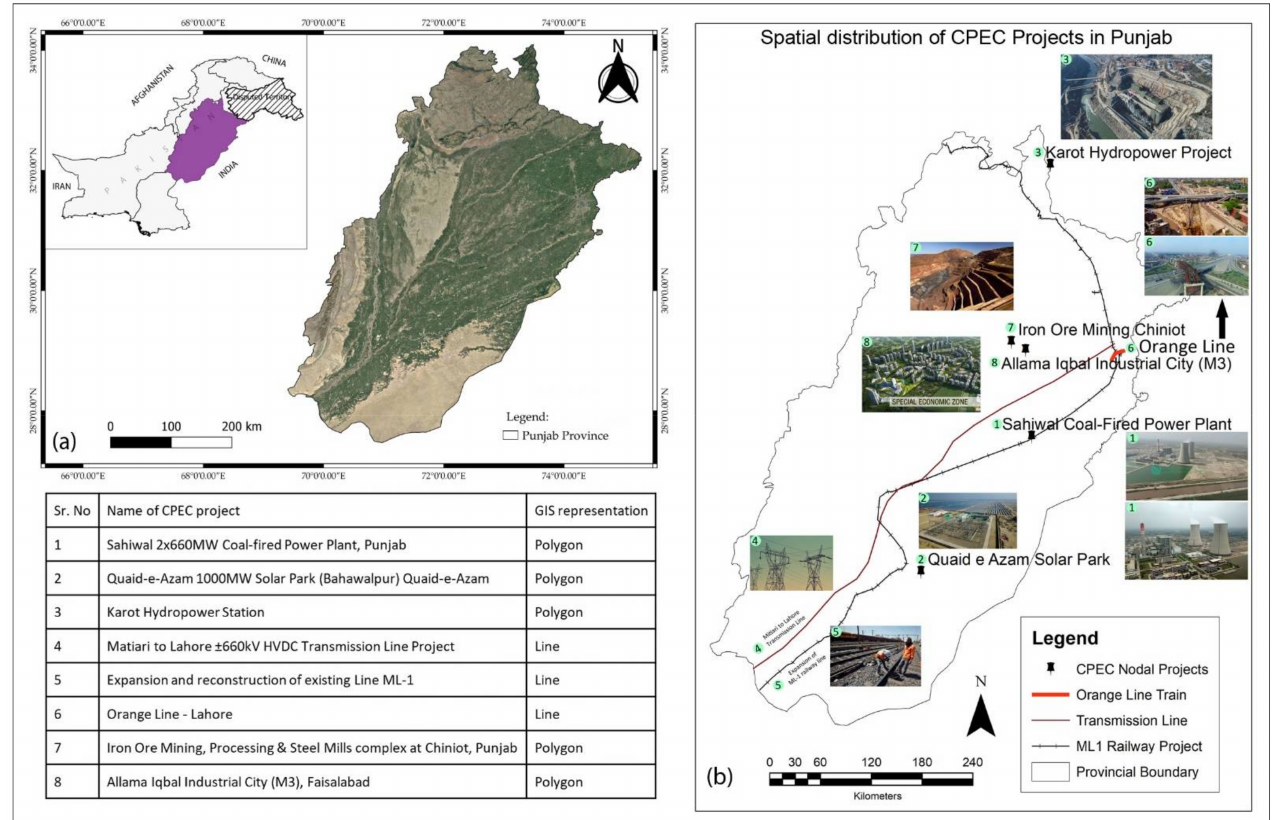
Figure 1. Map of the study area: ( a ) the map shows the geographical location of the key sector of Punjab province in Pakistan; ( b ) the map shows the spatial distribution of CPEC projects in the key sector of Punjab